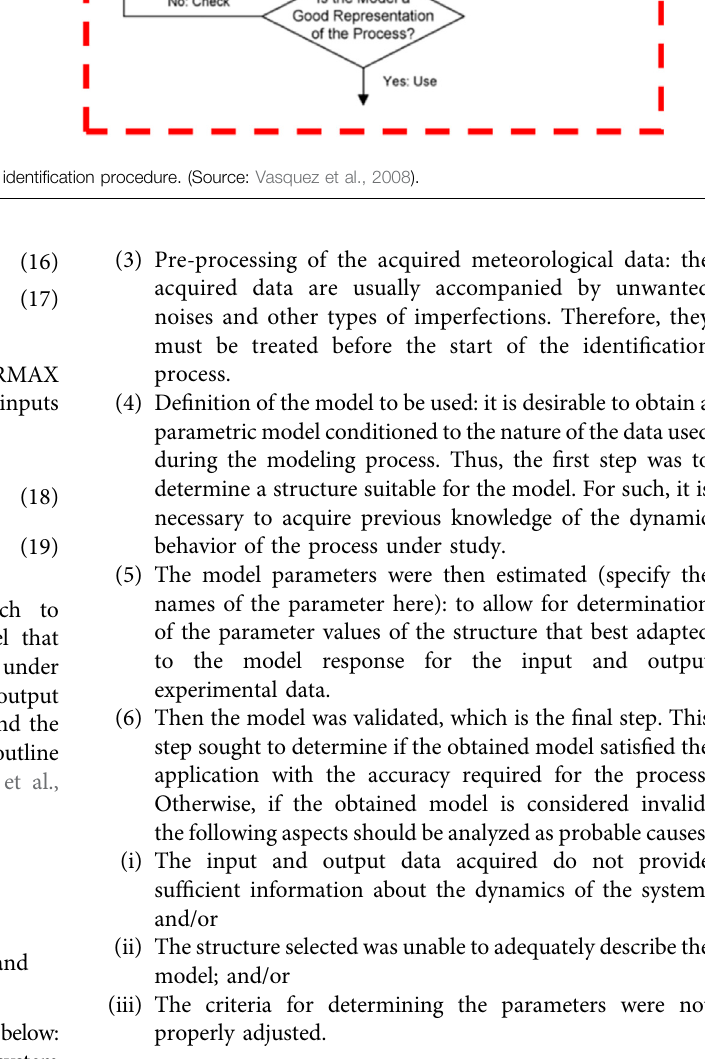
Frontiers in Energy Research |